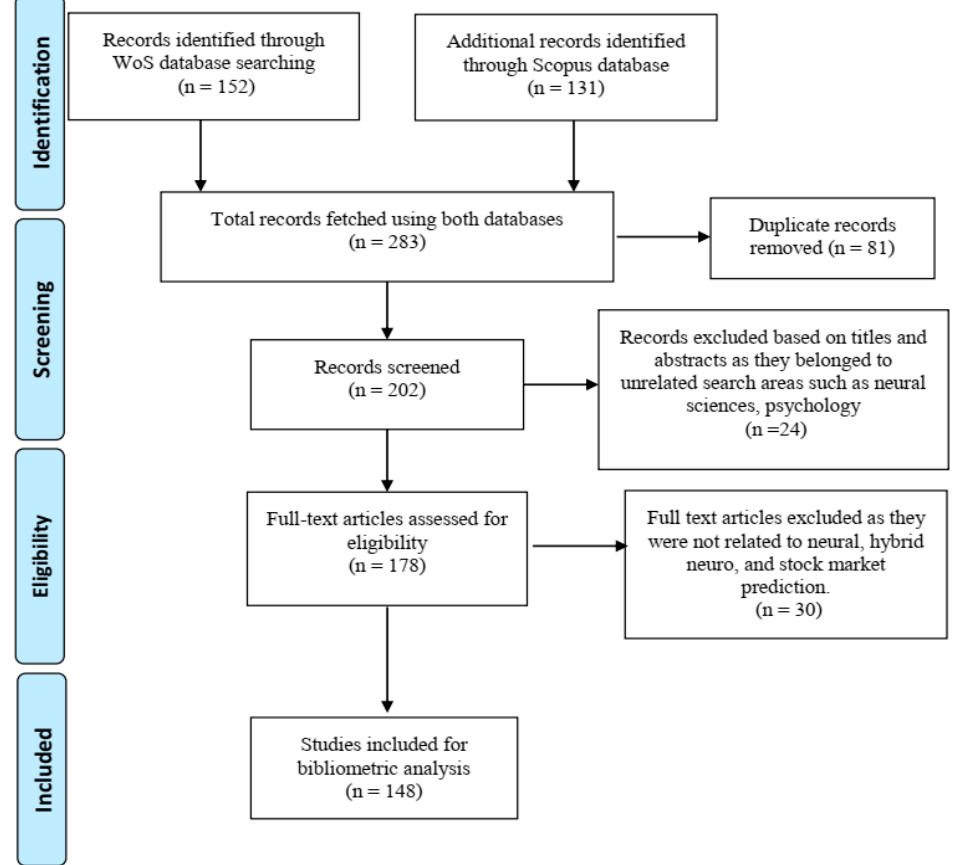
Figure 2. Study flow diagram.